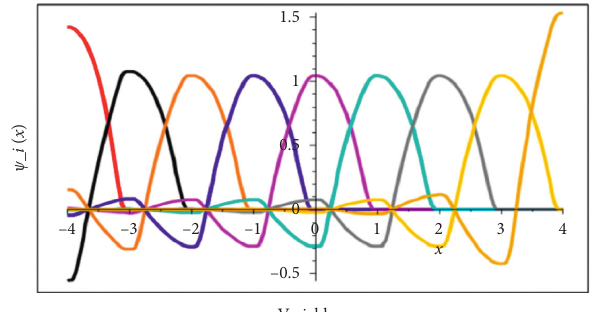
with 3 roots, lo- 4